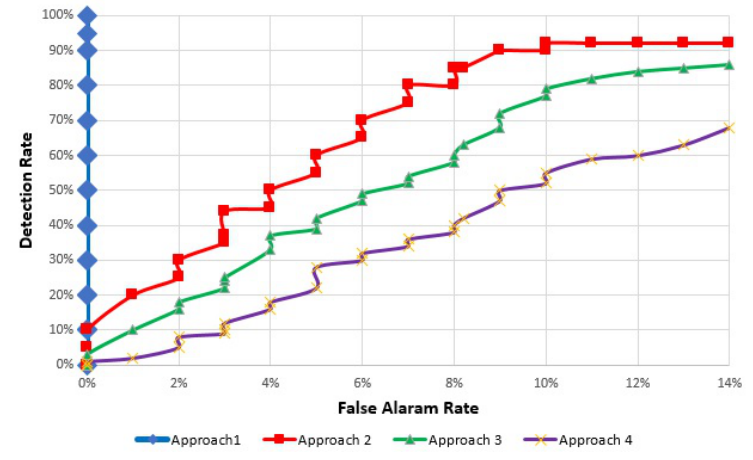
Figure 5. ROC curves examples for generic outlier detection approaches.